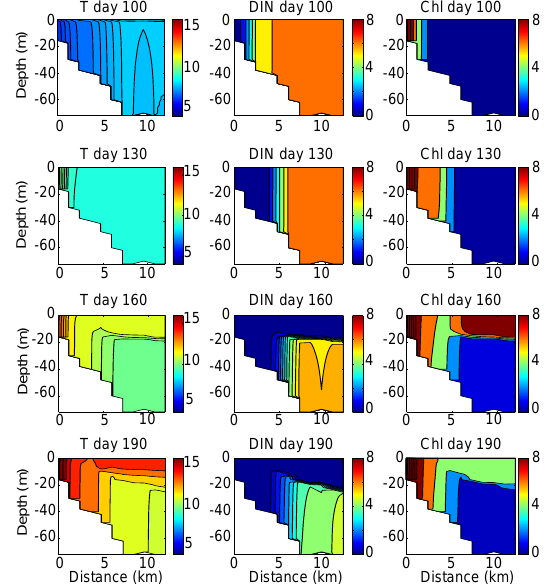
Figure 7. Sections through the developing tidal mixing front east of Lizard peninsula, along 50.017 ◦ N, on days 100, 130, 160 and 190 of 2013: temperature (left column); dissolved inorganic nitrate (mmolm − 3 , middle column); chl a (mgchl a m − 3 , right column).